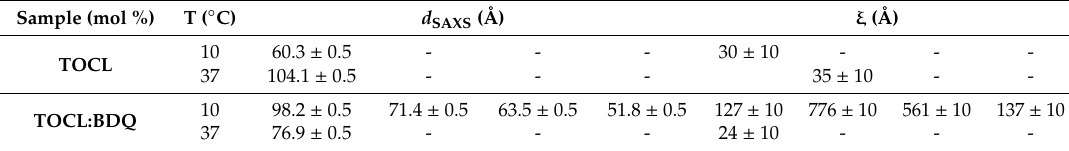
Table 7. SAXS di ff raction profiles of TOCL and TOCL with BDQ at 5% molar ratio at 10 and 37 ◦ C. Sample (mol %)